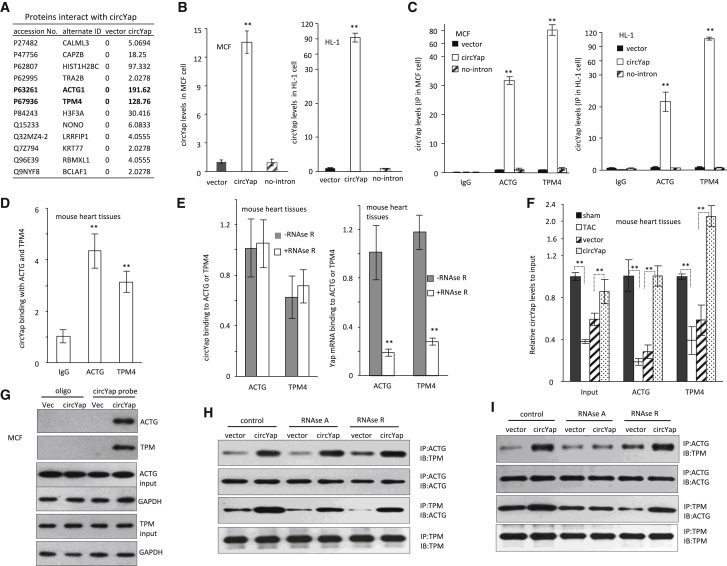
The Binding of circYap with ACTG and TPM4 Proteins(A) Mass spectrometry assay showing the proteins pulled down by circYap probe. (B) Expression of circYap in MCF and HL-1 cells transfected with circYap or the plasmids lacking an intron for circularization (no-intron). n = 3. ∗∗p < 0.01. (C) The binding of circYap with ACTG and TPM4 in MCF and HL-1 cells with or without circYap and its linear precursor (no-intron) overexpression. n = 3. ∗∗p < 0.01. (D) Antibodies against ACTG and TPM4 could precipitate circYap in mouse heart tissues. n = 3. ∗∗p < 0.01. (E) The binding of circYap or YAP mRNA with TPM4 and ACTG in mouse heart tissues with or without RNase R treatment. n = 4. ∗∗p < 0.01. (F) The binding of circYap with ACTG and TPM4 in pressure-overload heart tissues with or without circYap plasmid injection. n = 4. ∗∗p < 0.01. (G) The circYap probe pulled down ACTG and TPM4 proteins in MCF cells. (H) The binding of ACTG and TPM4 proteins in MCF cells upon circYap overexpression with RNase A or RNase R treatment. RNase A and RNase R were added after immunoprecipitation. n = 3. (I) The binding of ACTG and TPM4 proteins in MCF cells upon circYap overexpression with RNase A or RNase R treatment. RNase A and RNase R were added before immunoprecipitation. n = 3.